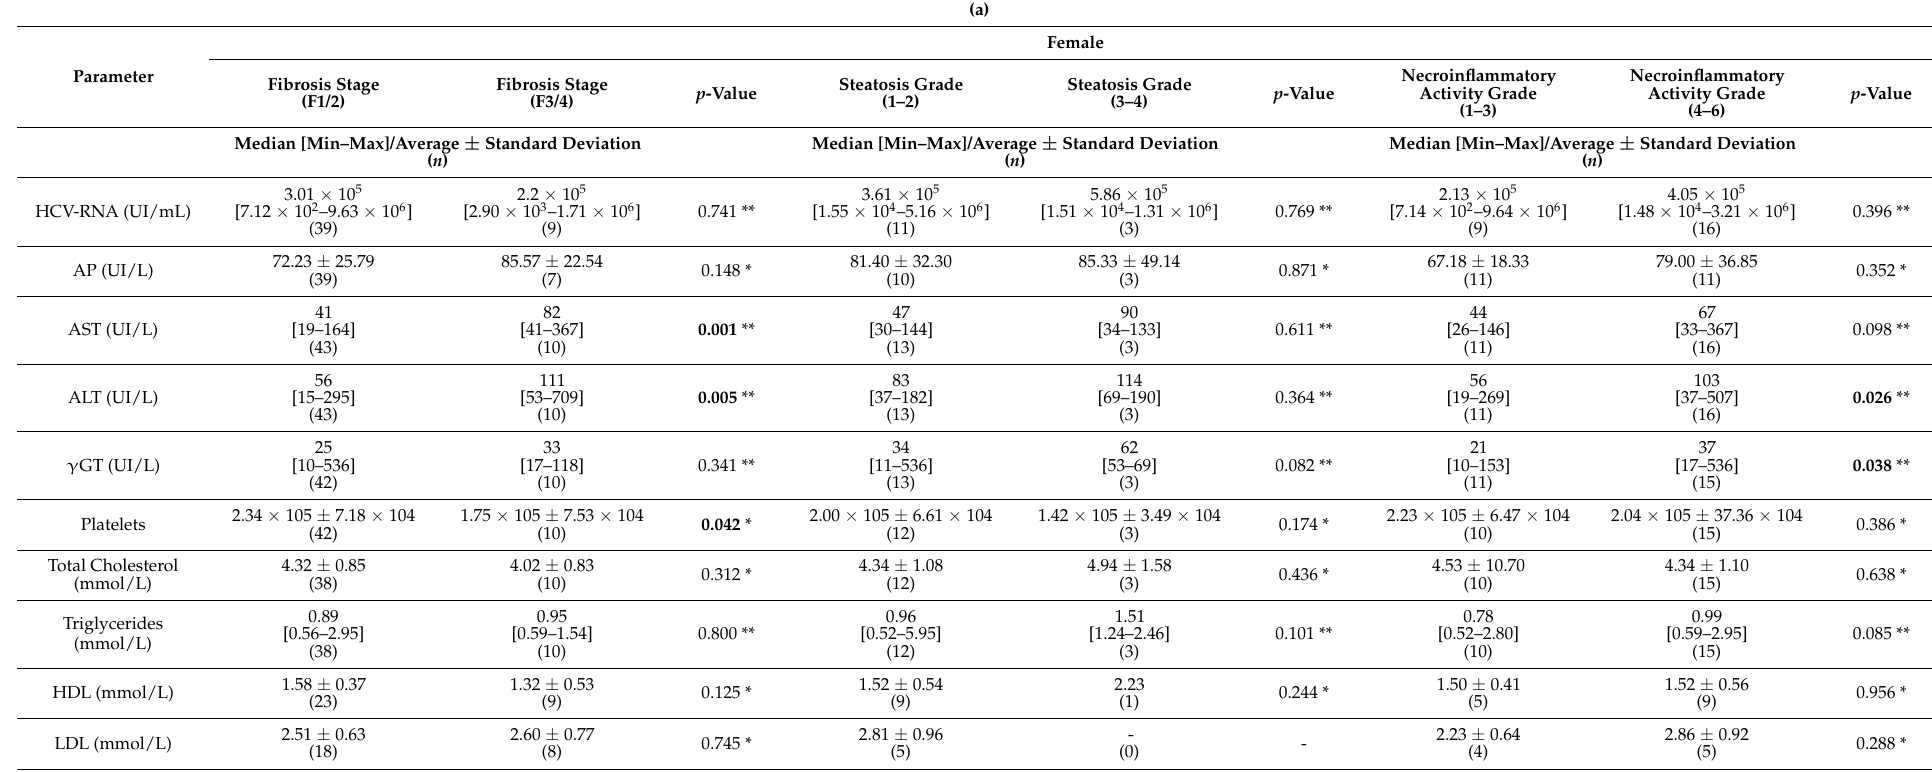
Table 4. Association of biochemical and histological